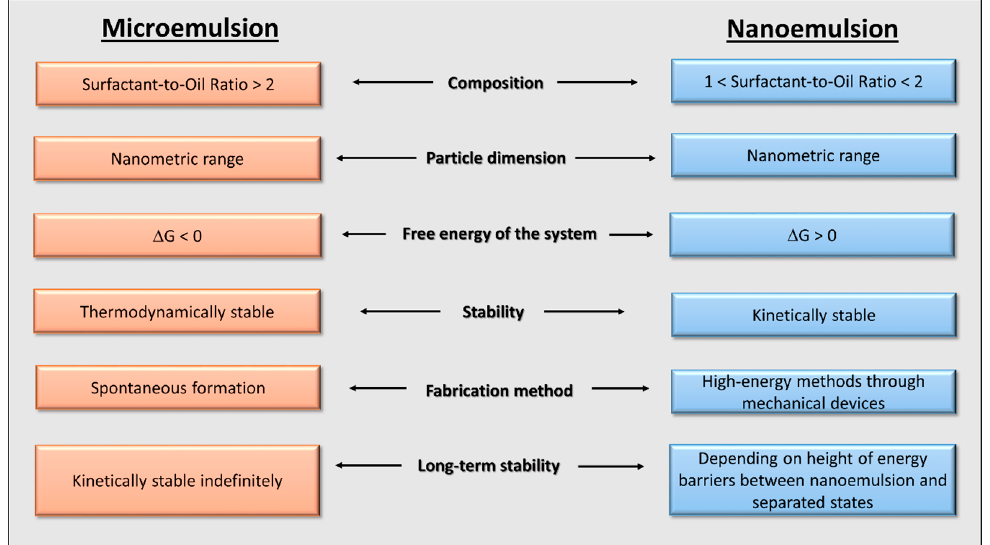
Figure 1. Comparison of the main physicochemical properties between micro- and nanoemulsion.